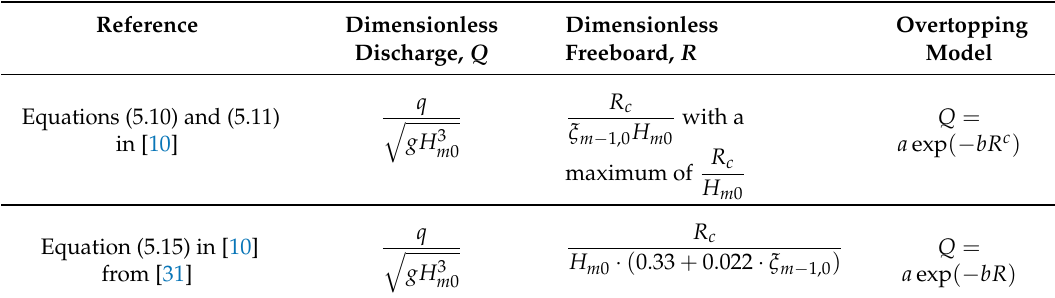
Table 3. Dimensionless discharge, dimensionless freeboard and overtopping models for the equations used in the comparisons, where q is overtopping discharge, R c is freeboard, H m 0 significant wave height, ξ m 1,0 is the Iribarren number, g is gravity, a and b are −